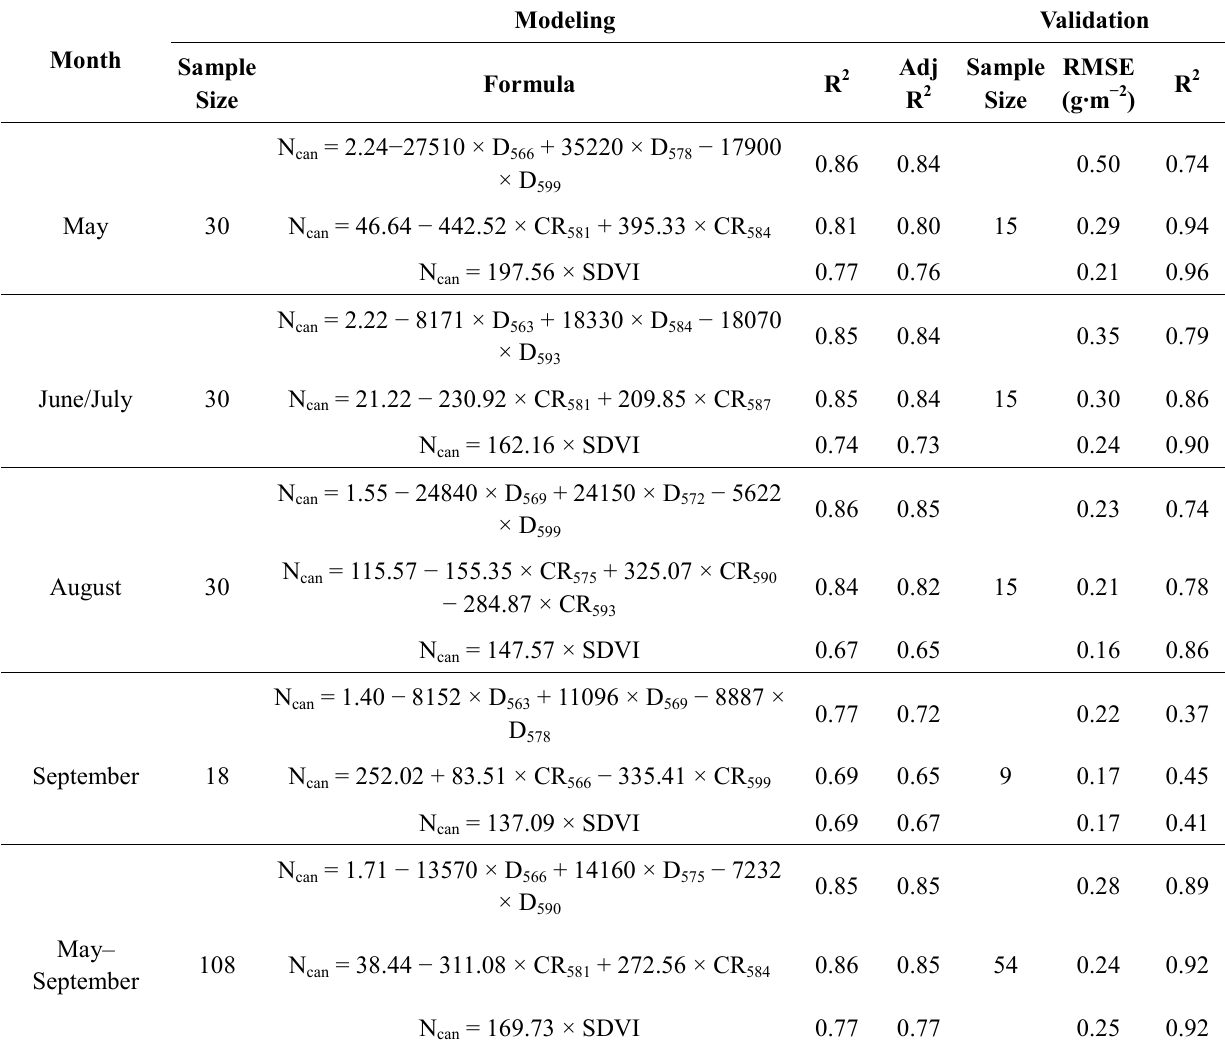
Table 5. Regression models for canopy nitrogen recovery using field-measured derivative (D), continuum removed reflectance (CR) spectra and